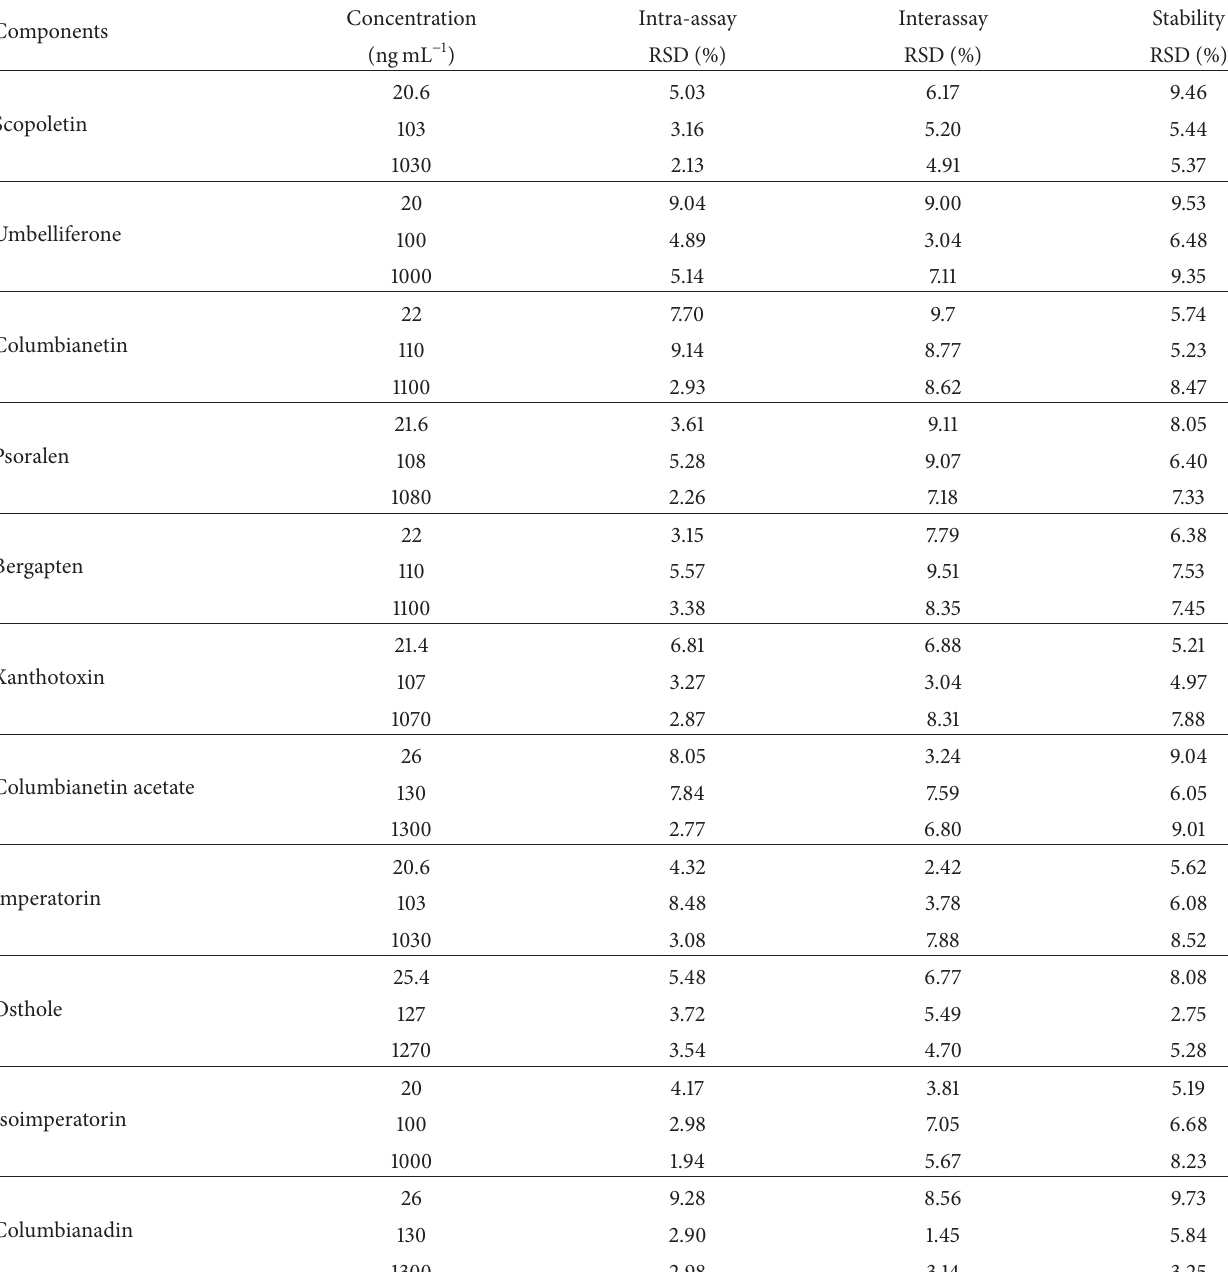
Table 3: Intra-assay and interassay precision of the developed method ( 𝑛 = 6